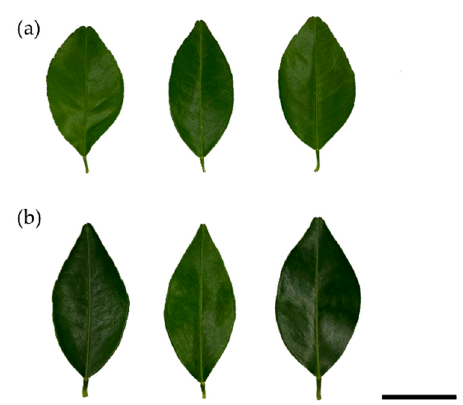
Figure 1. The ovate leaf and narrow-winged leaf petiole of two accession s ( a ) OWD and ( b ) GS-1 of Citrus depressa in Taiwan. The line represents 3 cm in